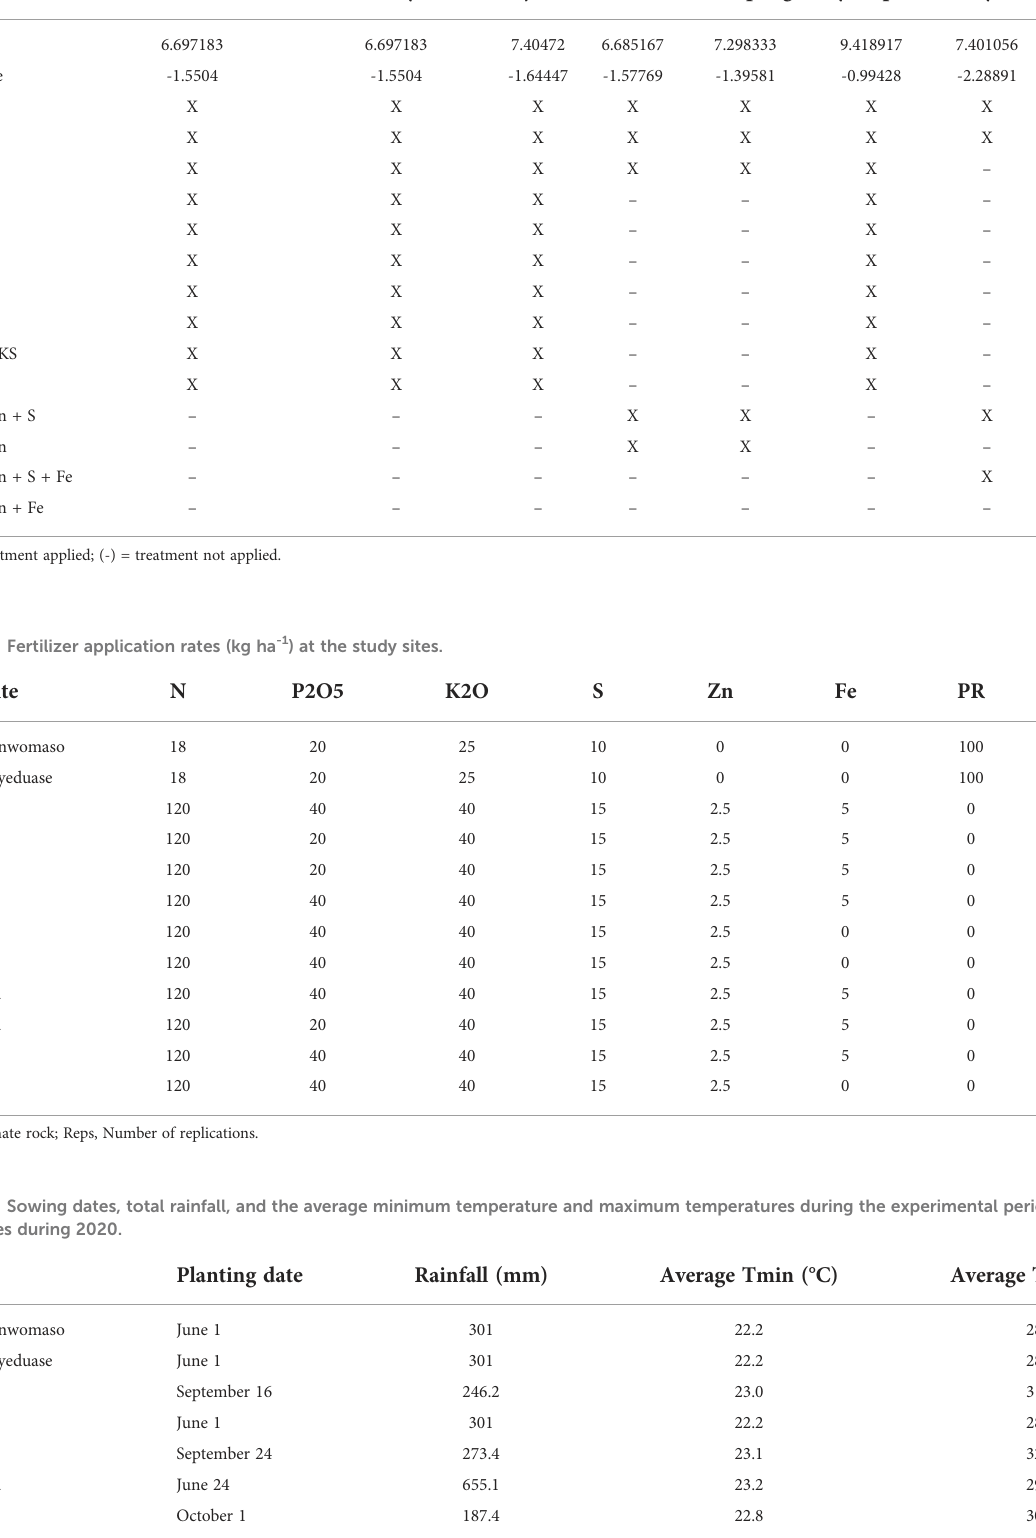
September 24 June